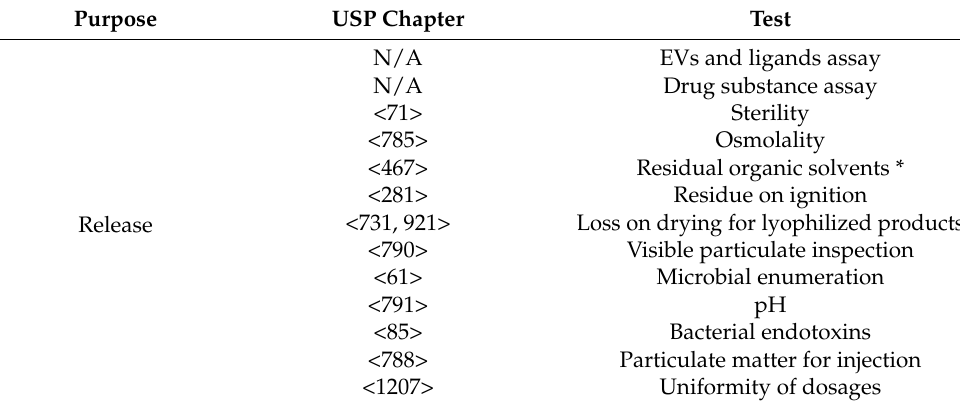
Table 4. Release tests for EV drug products (USP).